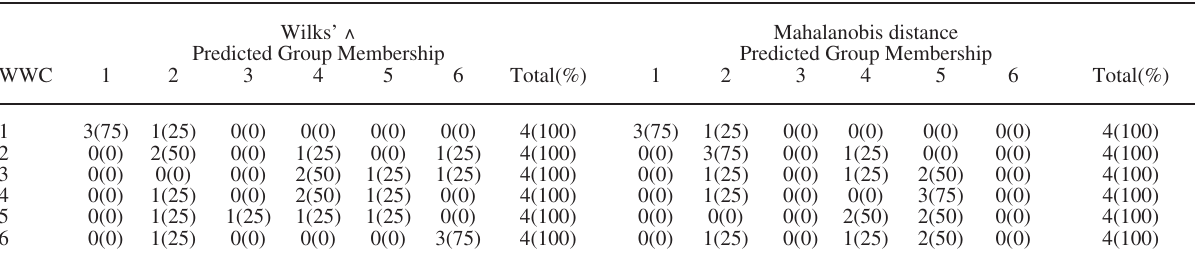
Table 8. – original classification results used in the discriminant analysis with the two methods: Wilks’ lambda ( ∧ ) and the Mahalanobis distance. WWc, wet-weight classes.